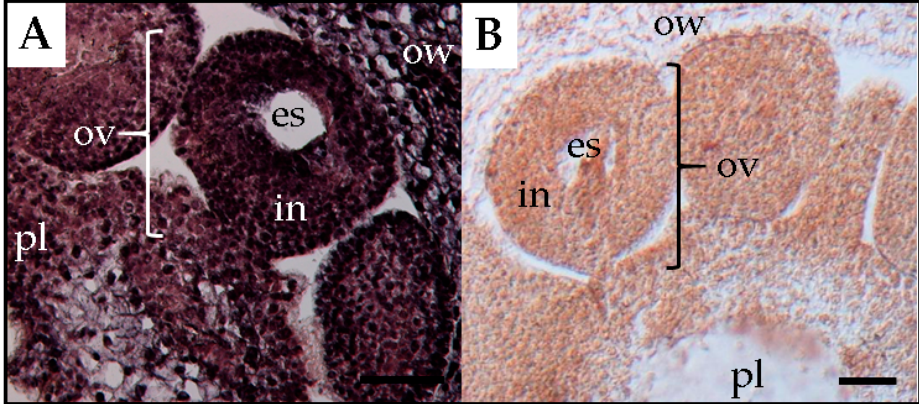
Figure 4. In situ hybridization shows the presence of potato spindle tuber viroid in the placenta, ovule, and ovary wall in flowers of an infected tomato plant ( A ) and a healthy tomato plant ( B ) at the flower opening stage. es, embryo sac; in, integuments; ov, ovule; ow, ovary wall; pl, placenta. Scale bars = 50 μ m.